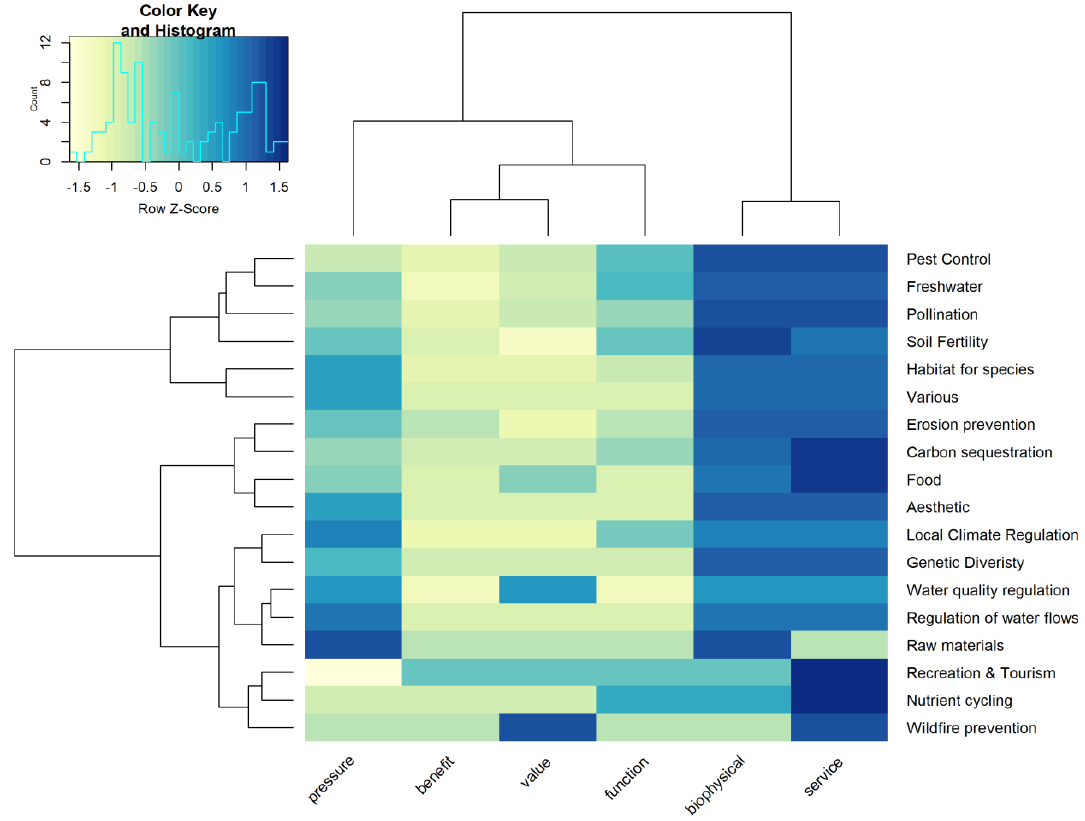
Figure 4. An overview of the ecosystem service cascade model stage associated with different ecosystem services. Dendrograms obtained through hierarchical clustering, and using Jaccard distance, represent similar association of studies in terms of the studied ecosystem service cascade model stage (columns) and the identified ecosystem services (rows). Table 1. Number of ecosystem service indicators as categorised into capacities, flows and benefits.